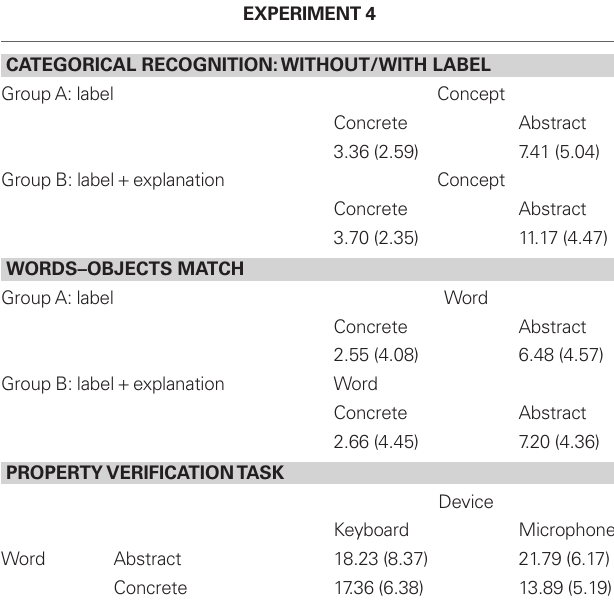
Table 4 | errors percentages and standard deviations (in parenthesis) for each TeST of experiment